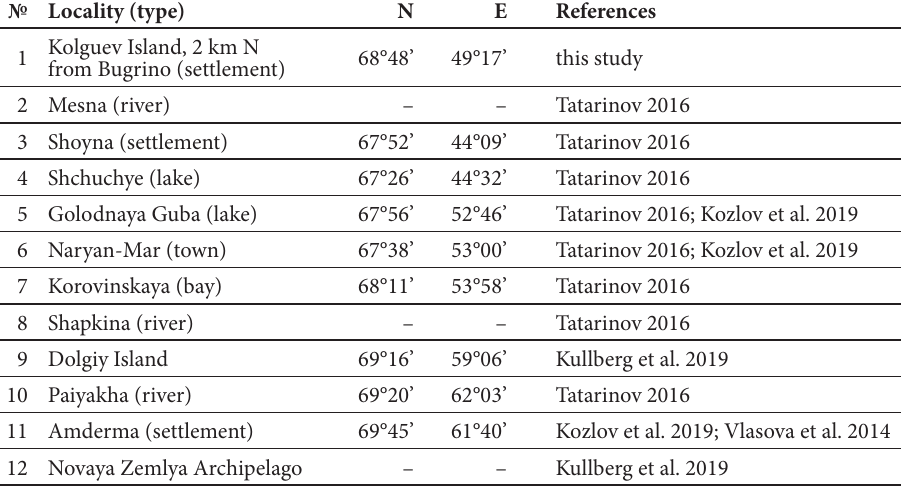
Table 1. List of records of Boloria frigga in the north-eastern part of European Russia. № Locality (type) N